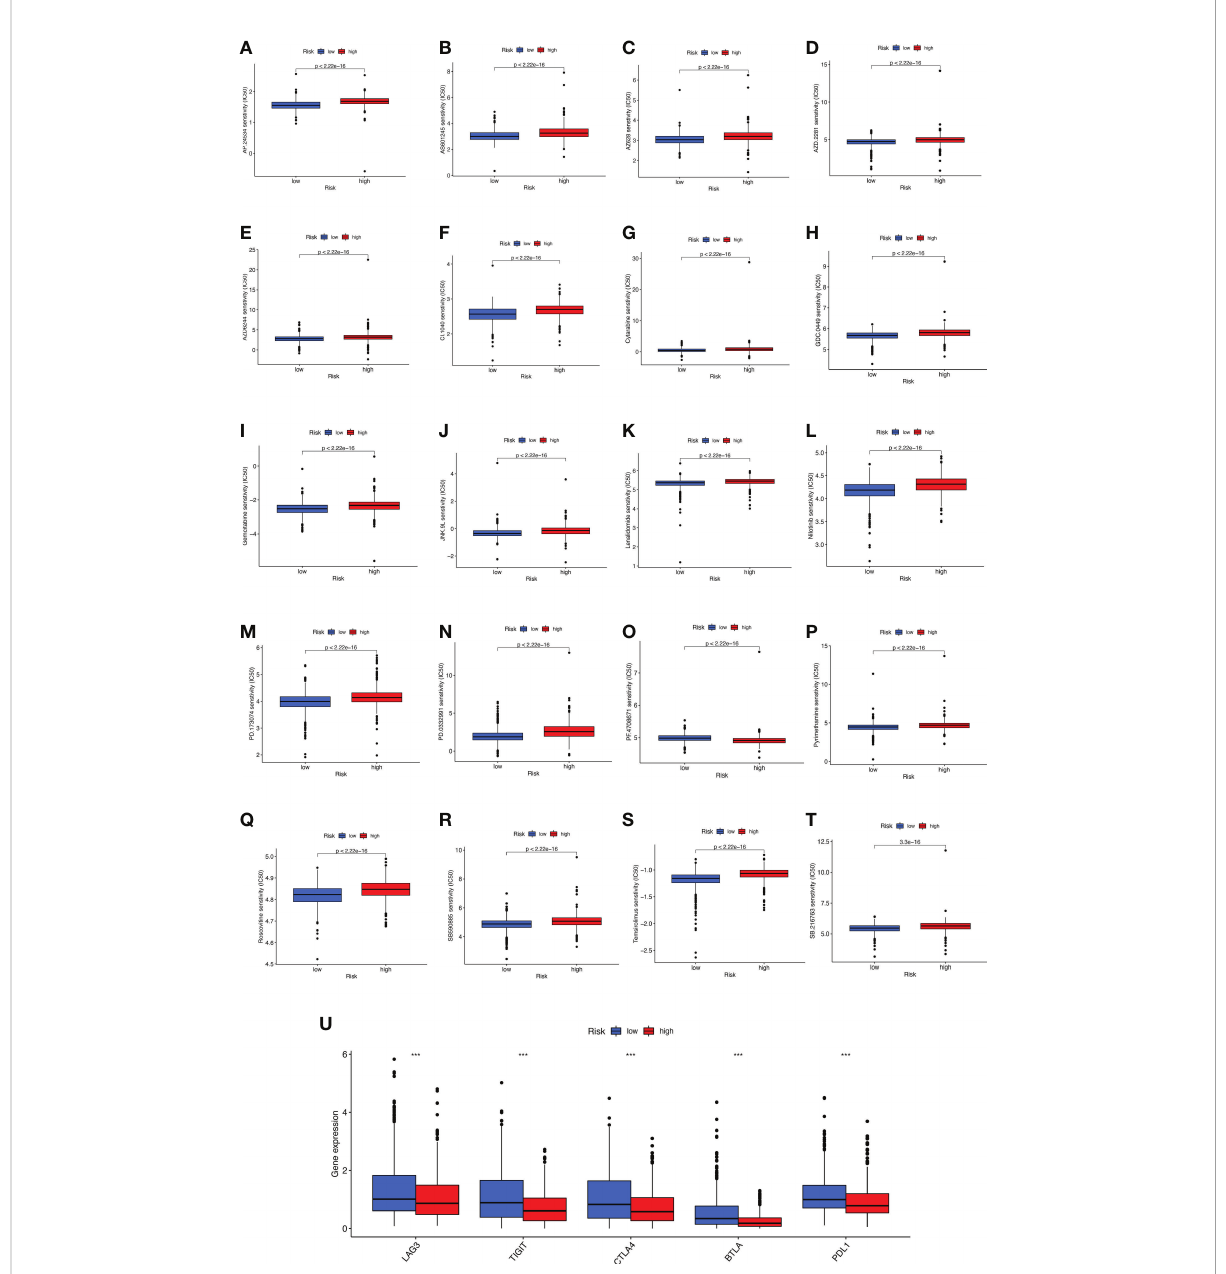
FIGURE 10 Analyses of potential drug sensitivity and immune checkpoint gene expression between high- and low-risk groups. (A – T) The boxplots for drug sensitivity analysis of (A) AP.24534. (B) AS601245. (C) AZ628. (D) AZD.2281. (E) AZD6244. (F) CI.1040. (G) Cytarabine. (H) GDC.0449. (I) Gemcitabine. (J) JNK.9L. (K) Lenalidomide. (L) Nilitinib. (M) PD.173074. (N) PD.0332991. (O) PF.4708671. (P) Pyrimethamine. (Q) Roscovitine. (R) SB590885. (S) Temsirolimus. (T) SB.216763. (U) Immune checkpoint genes differential expression analysis. ***p <